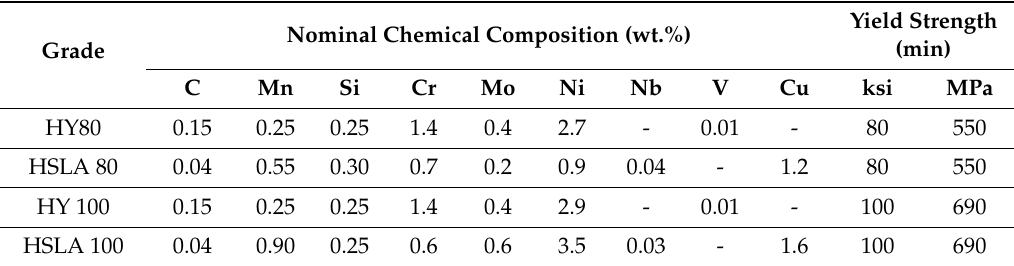
Table 4. Nominal chemical composition and Yield Strength of High tensile steels [55]. Nominal Chemical Composition (wt.%) Grade